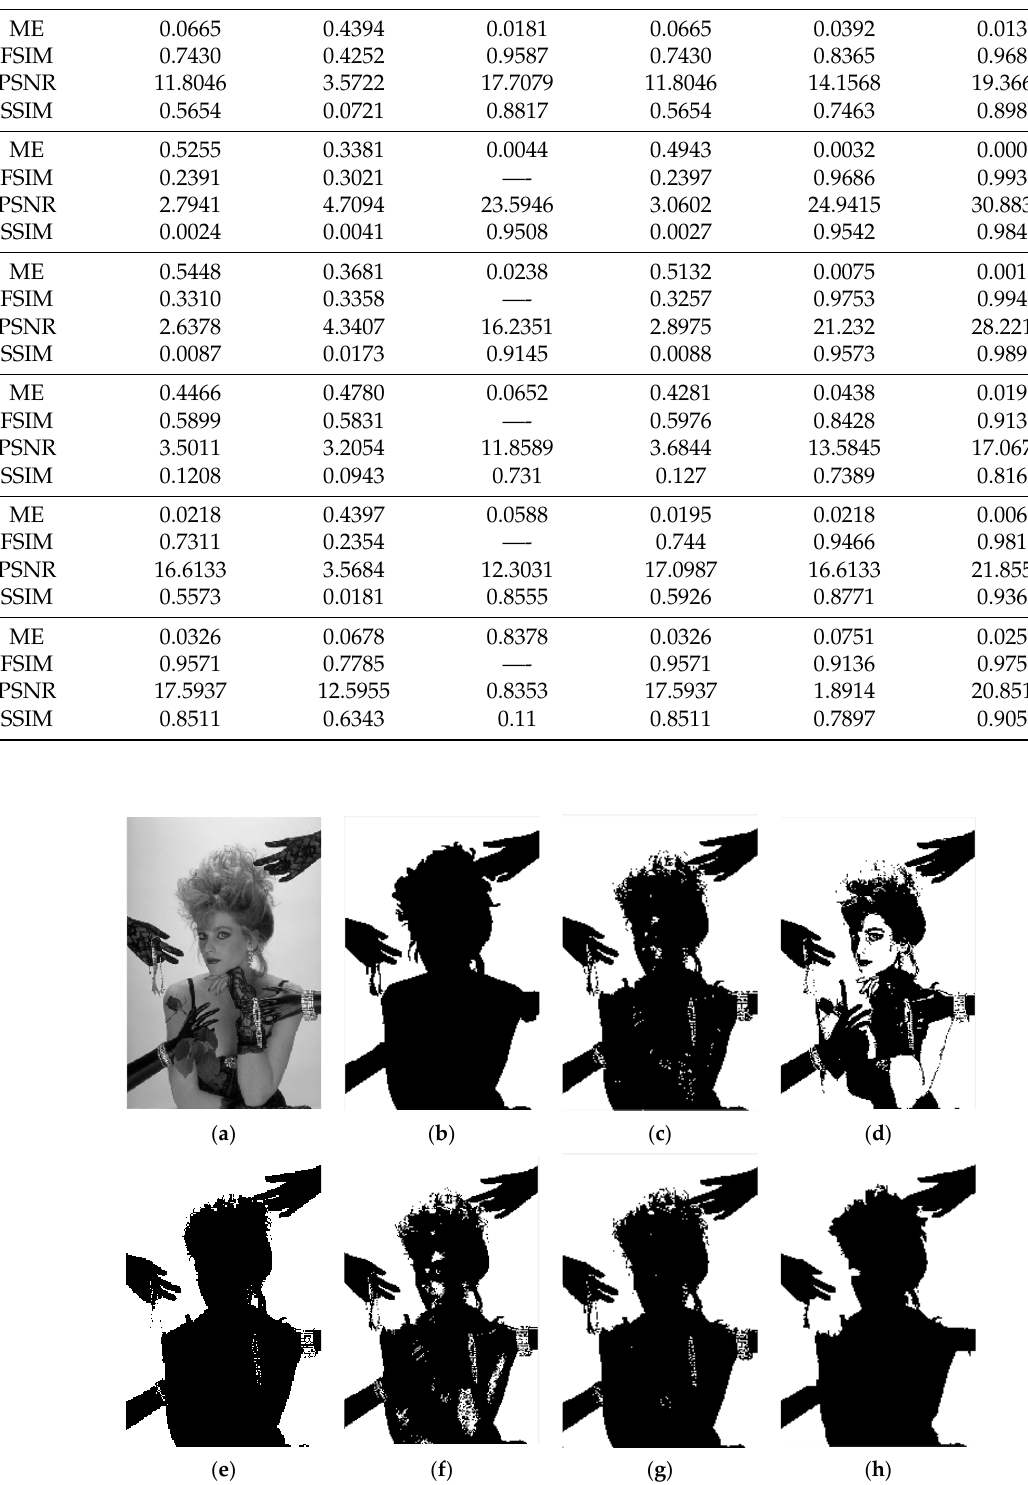
( h ) Figure 13. #227046 and its segmentations: ( a ) #227046, ( b ) ground-truth, ( c ) Otus, ( d ) MRCUT, ( e ) EITMIS, ( f ) NSWCC, ( g ) IT2FSWCC, ( h ) FSEFTISRI.